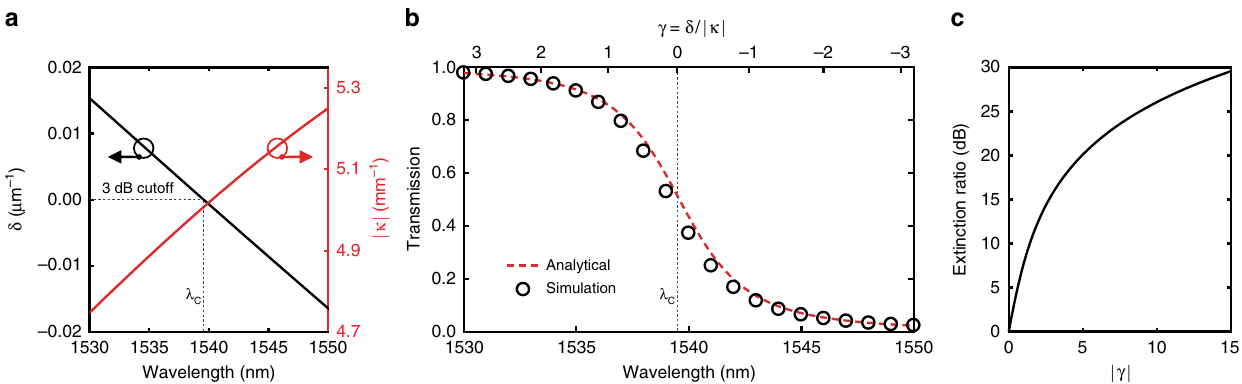
Fig. 2 Power roll-off in the spectrally selective waveguide. a Effective index difference δ and the coupling coef fi cient κ as functions of wavelength ( λ ) around the desired cutoff in the C-band. At the 3 dB cutoff wavelength λ C , δ = 0 and γ = δ /| κ | = 0. For this speci fi c design, δ ( λ < λ C ) > 0 and δ ( λ > λ C ) < 0. The wavelength-dependent change in the overlap and the coupling coef fi cient is primarily in fl uenced by waveguide dispersion due to larger spatial pro fi les of individual waveguide modes ψ A and ψ B at longer wavelengths. Speci fi cally, κ changes by about only 10% from 1530 to 1550 nm, whereas δ changes from positive to negative. b The expected transmission response | T A | at WG A , as a function of wavelength. With increasing wavelength, majority of the optical power shifts from WG A to WG B , following the observed shift in the mode pro fi le of ψ + . Analytical solution is calculated from the coupled mode analysis result in Eq. (3). Simulated results are obtained from ratios of Poynting vector fl uxes through regions surrounding WG A and WG B to the total fl ux